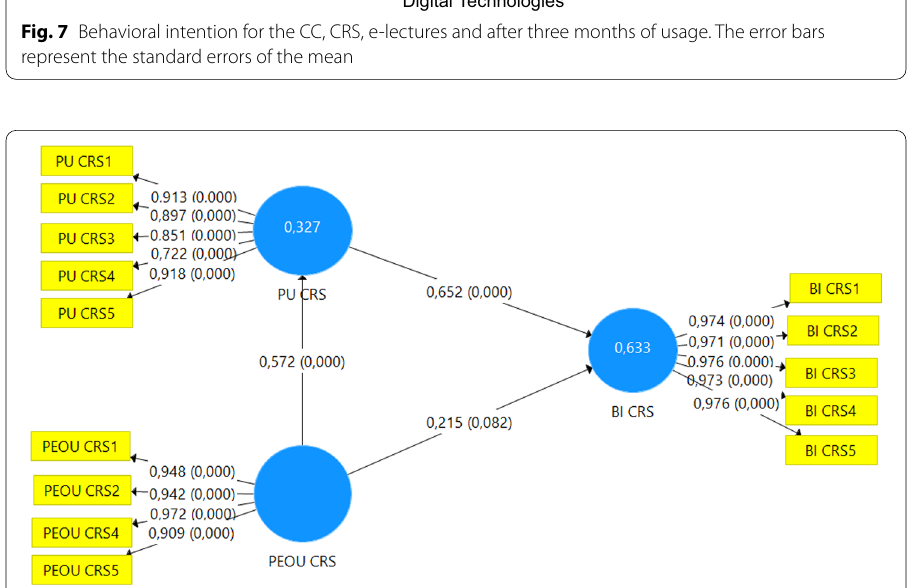
Fig. 8 PLS-SEM model showing PU, PEOU and BI with their manifest variables. The path loadings are shown on path with the p-values in